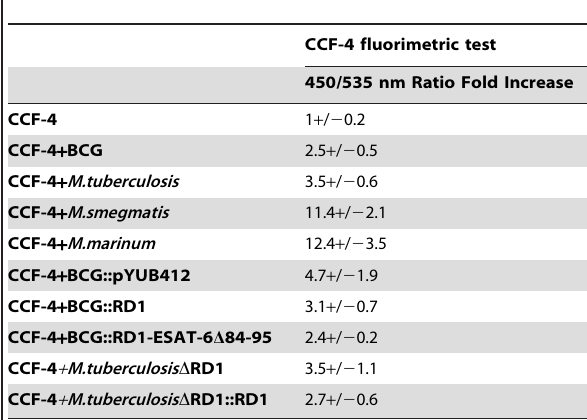
Table 1. M. marinum , M. smegmatis , M. tuberculosis and